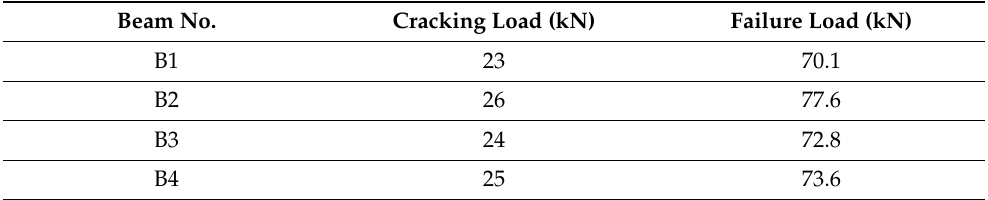
Table 4. Summary of the recorded results under monotonic loading.